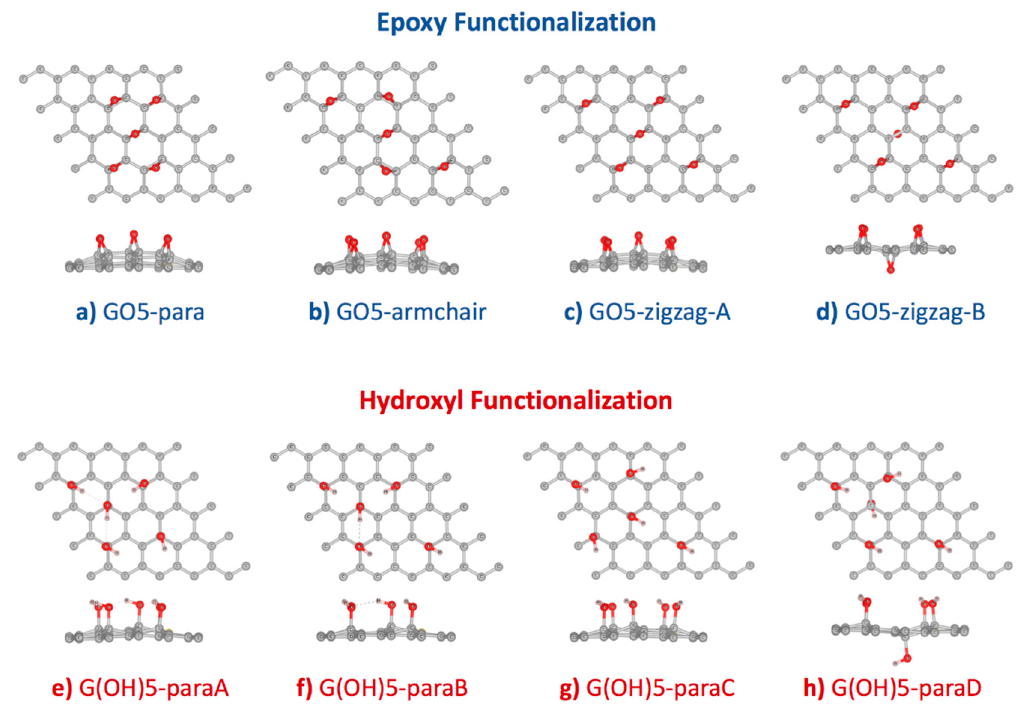
Figure 1. Optimized configurations of ( a – d ) 5 × 5 graphene supercell functionalized by five epoxy groups, and ( e – h ) 5 × 5 graphene supercell functionalized by five hydroxyl groups. Starting configurations followed Domancich et al. [42]. Table 1. Formation energy of five epoxy or hydroxyl groups on the 5 × 5 graphene supercell under configuration proposed by Domancich et al. Epoxy Functionalization Hydroxyl System